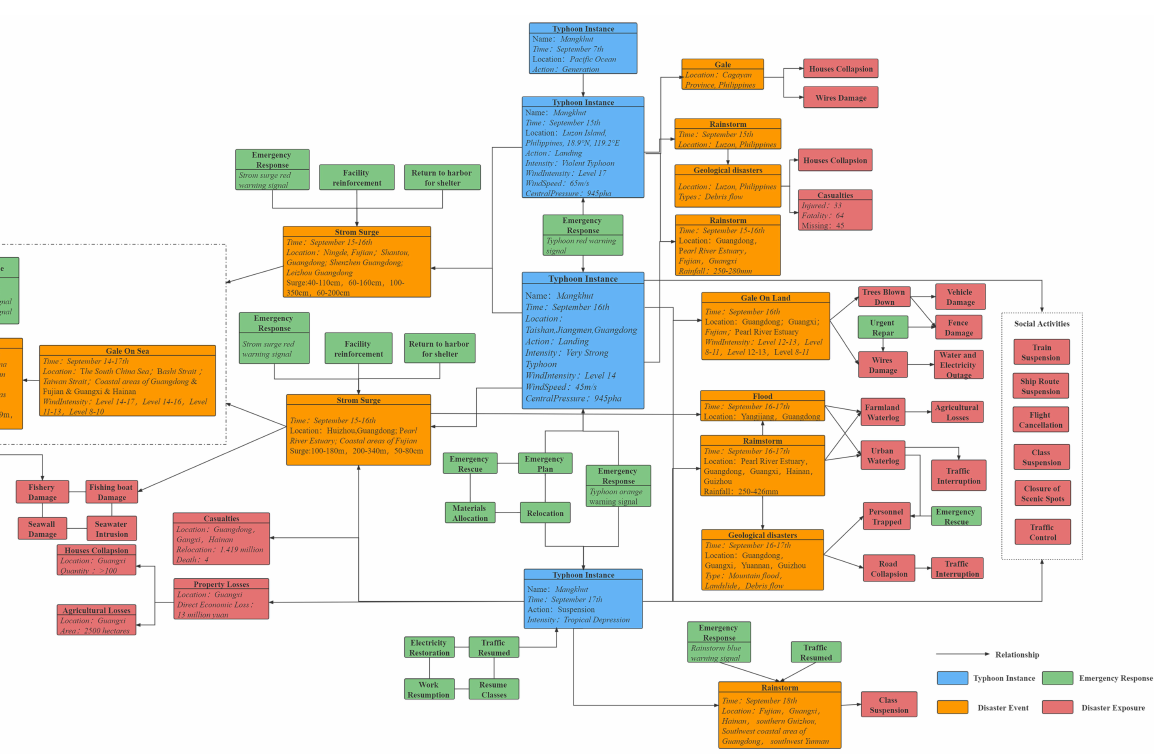
Figure 11. The disaster chain of Typhoon